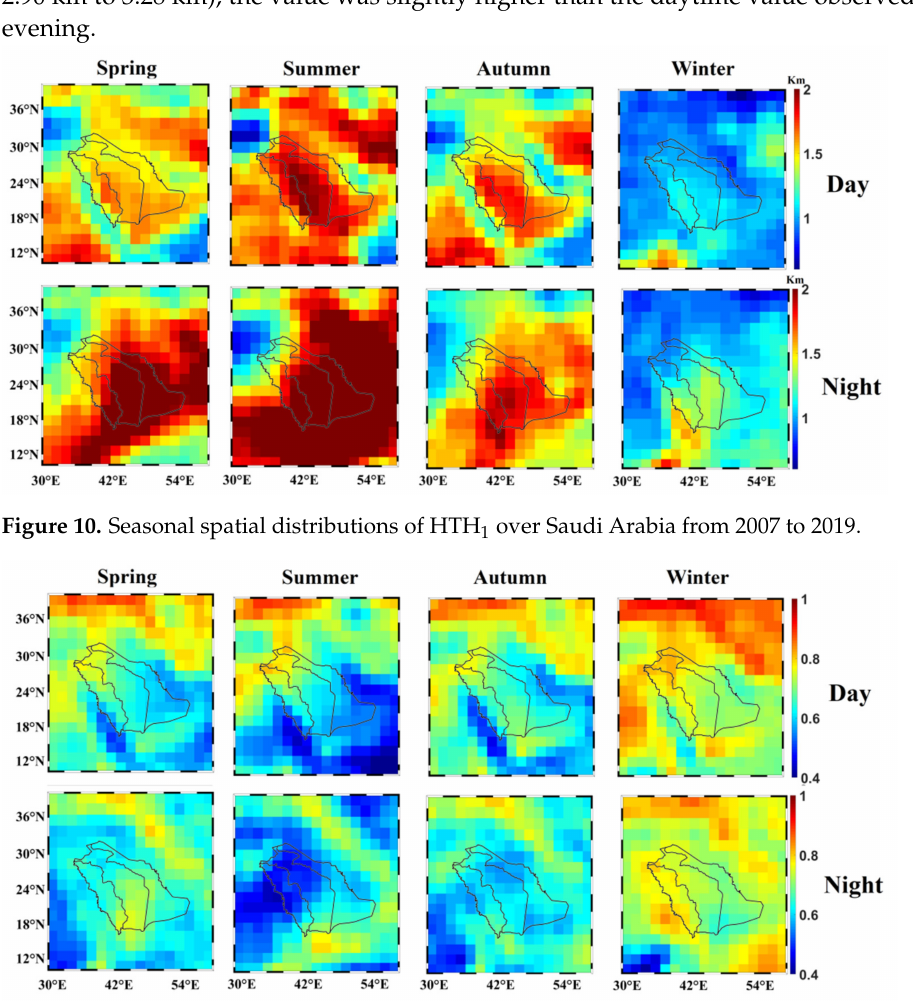
Figure 11. Seasonal spatial distributions of PAOD 1 over Saudi Arabia from 2007 to